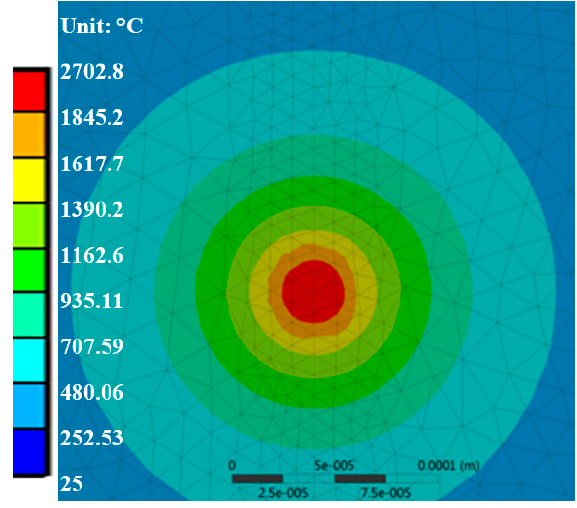
Figure 3. The transient thermodynamic model with loaded boundary conditions.